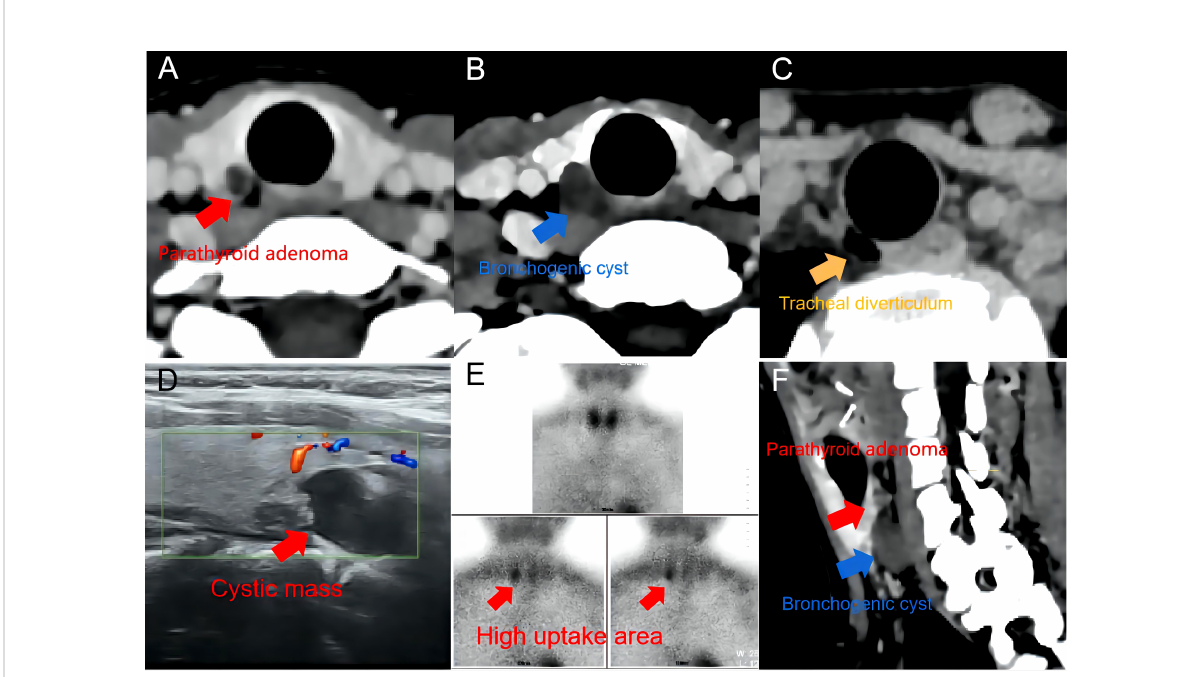
FIGURE 1 Imaging examination. (A – C) adenoma, cervical bronchogenic cyst, and tracheal diverticulum in CT. (D) a hypoechoic nodule in ultrasound. (E) 99mTc-sestamibi single-photon emission computed tomography: Delayed uptake (120min) in the lower panel suggests a parathyroid source. (F) CT multiplanar reformation (CT-MPR) of the